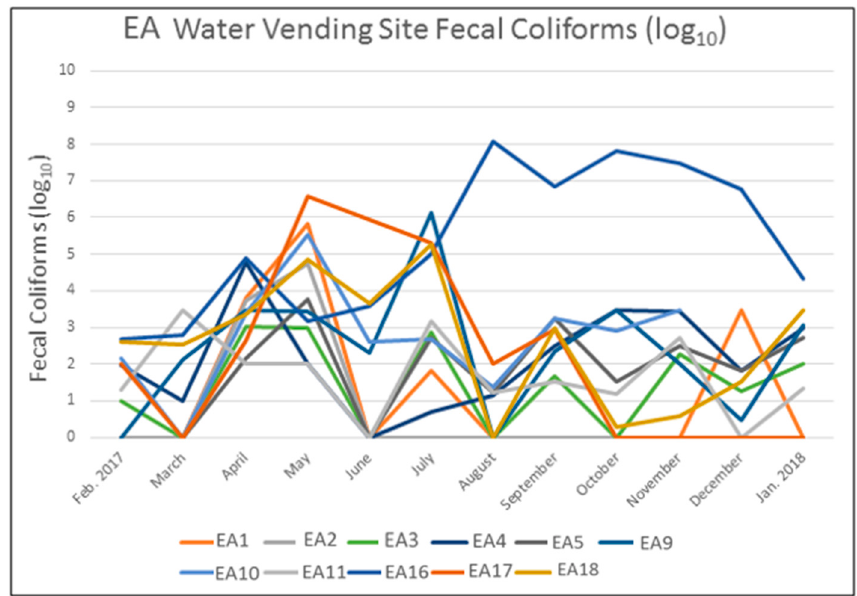
Figure 5. Fecal Coliform counts per month for the water point testing sites in the EA neighborhood.